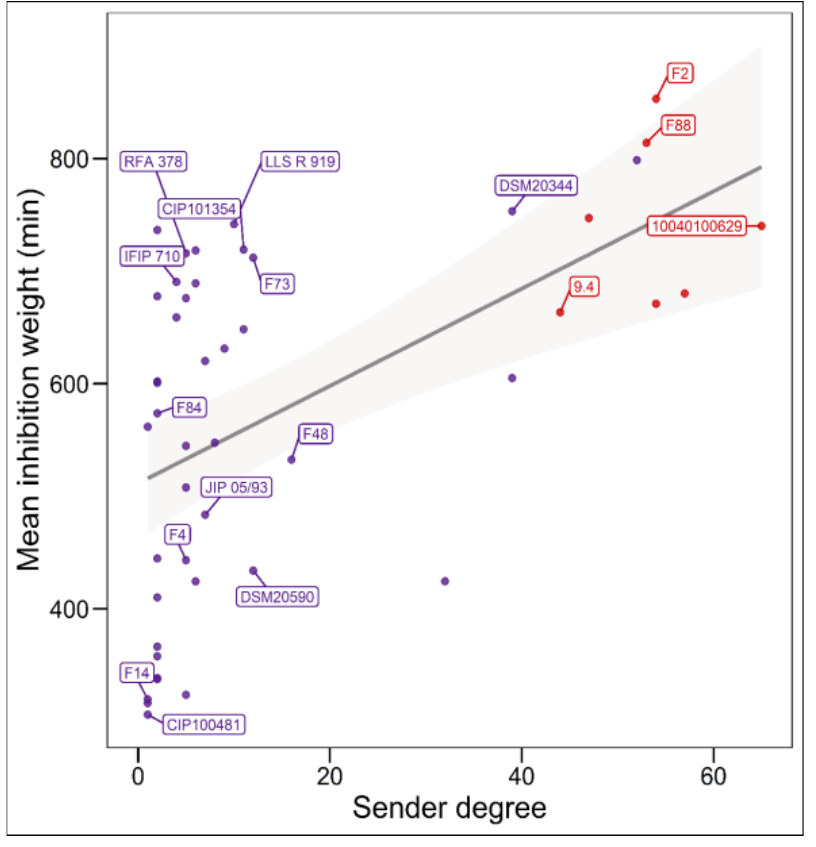
Figure 2. Relationship between the sender degree, the inhibitory potency, and the ability to inhibit L. monocytogenes EGDe. The sender degree refers to the number of receiver C. maltaromaticum strains inhibited by a given sender C. maltaromaticum strain. The mean inhibition weight is the mean of GII values corresponding to inhibitions and recorded for each sender strain. Only strains for which the sender degree is different from 0 and for which the genome was analysed in this study are labelled. Simple linear regression modelling was performed ( p -value = 8.8 × 10 − 5 , R 2 = 0.29), the grey shaded area denotes the 95% confidence intervals ( p -value < 0.05). Clustering analysis was performed on the basis of intraspecific inhibition spectra of the 29 strains that were subsequently selected for genome mining. The strains were clustered into three groups: gp1, gp2, and gp3 encompassing 5, 17, and 7 strains, respec- tively (Figure 3). The strains from gp2 and gp3 have a narrow inhibitory spectrum of C. maltaromaticum strains and weakly inhibit L. monocytogenes EGDe. Conversely, the strains that belong to gp1 have a wide spectrum of inhibition of C. maltaromaticum as well as a high potency of inhibition of L. monocytogenes EGDe ( p -values < 0.001, Figure 4). However, not all strains of gp1 are characterized by high anti- L. monocytogenes EGDe potency since among the five strains, the strain DSM20344 is a weak inhibitor of the pathogen (Figure